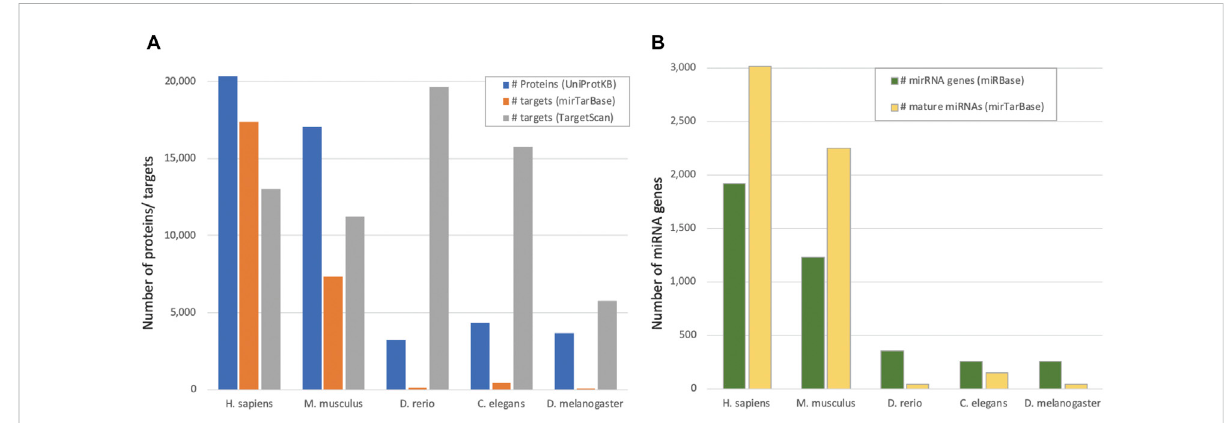
FIGURE 1 miRNAsandregulatedgenesbyspecies. (A) NumberofproteinsfromUniProtKB/SwissProtreportedas “ reviewedproteome ” (seeMethods)and the number of reported targets from mirTarBase as high con fi dence (by evolutionary conservation) reported by TargetScan, for fi ve model organisms. (B) . The number of miRNA stem-loop genes (miRBase) and mature miRNAs (miRTarBase) for the model organisms as in (A)